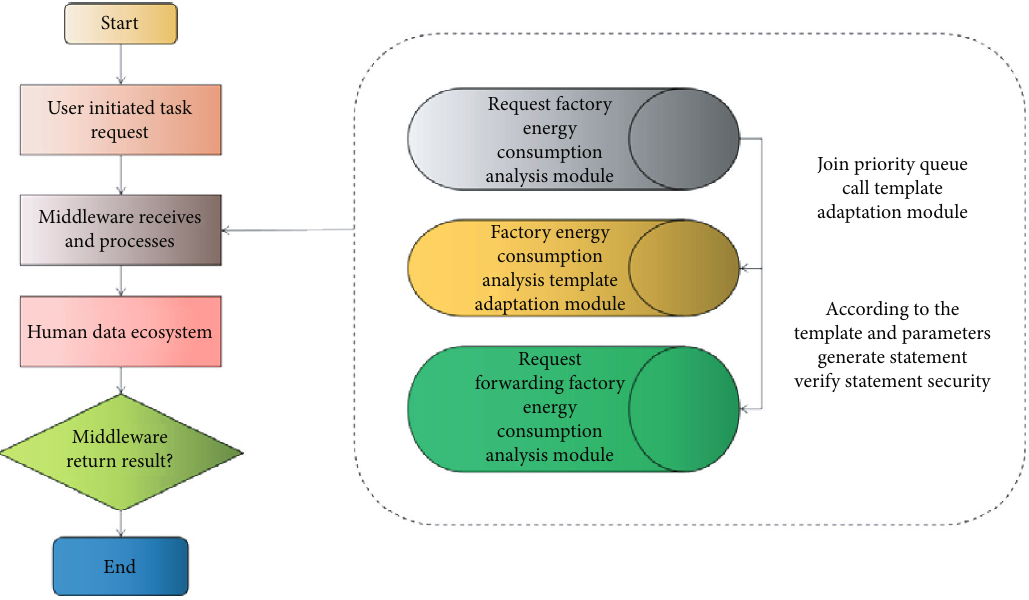
Figure 1: Internet of Things fl ow chart of big data ecosystem.